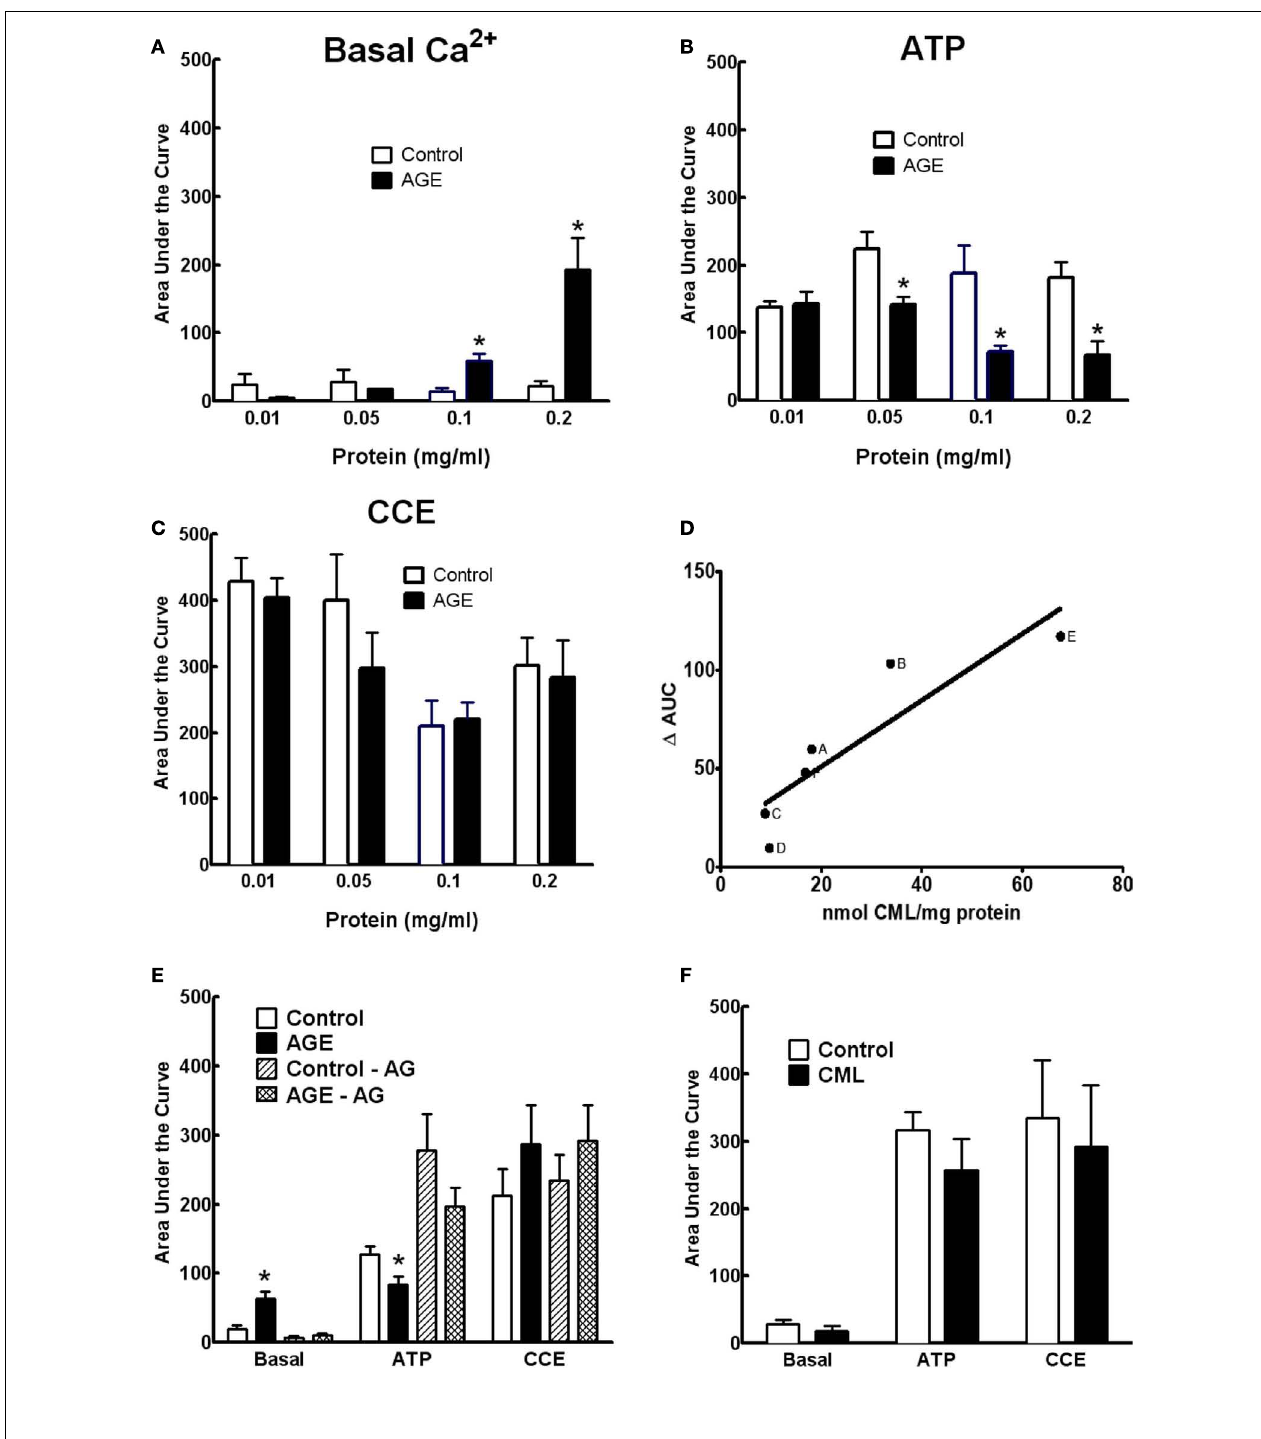
AGE sample (50mM G6P/60days) co-incubated with aminoguanidine (AG, 25mM) did not alter Ca 2 + signaling, compared with AGE not containing AG. (F) CML (6 µ M) did not alter Ca 2 + signaling in BAEC. Points and columns represent the mean ± SEM of five to six recordings. *Indicates significant effect of AGE compared to control ( P < 0.05, t